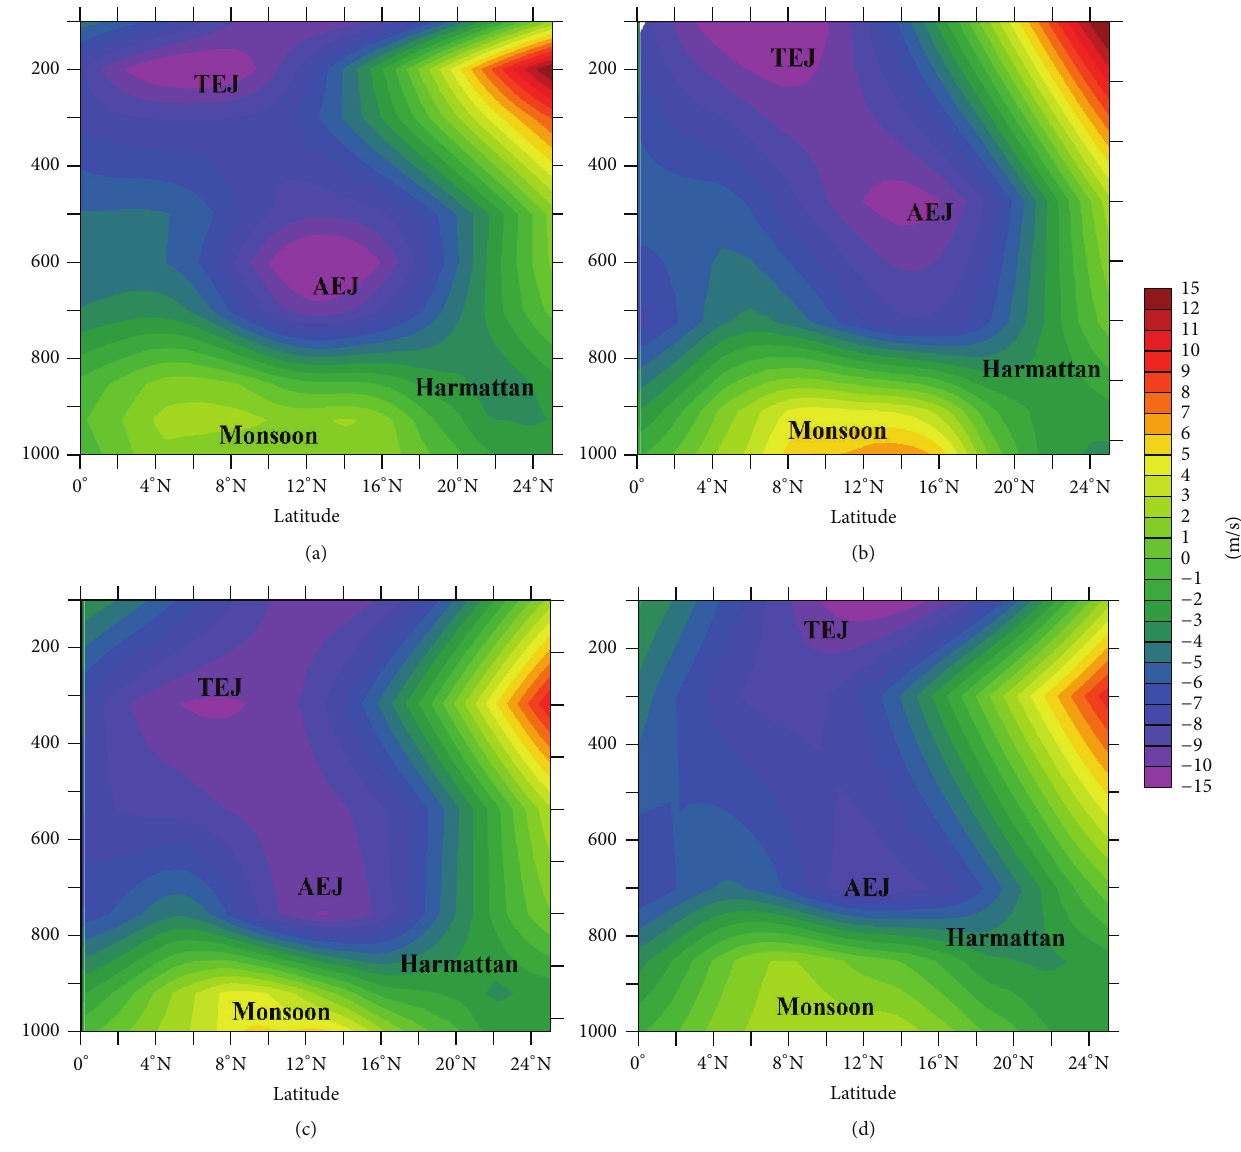
Figure 8: The vertical cross section of the zonal wind over West Africa from 1990 to 2008 for (a) ERA-Interim, (b) CCLM, (c) RCA, and (d) REMO during